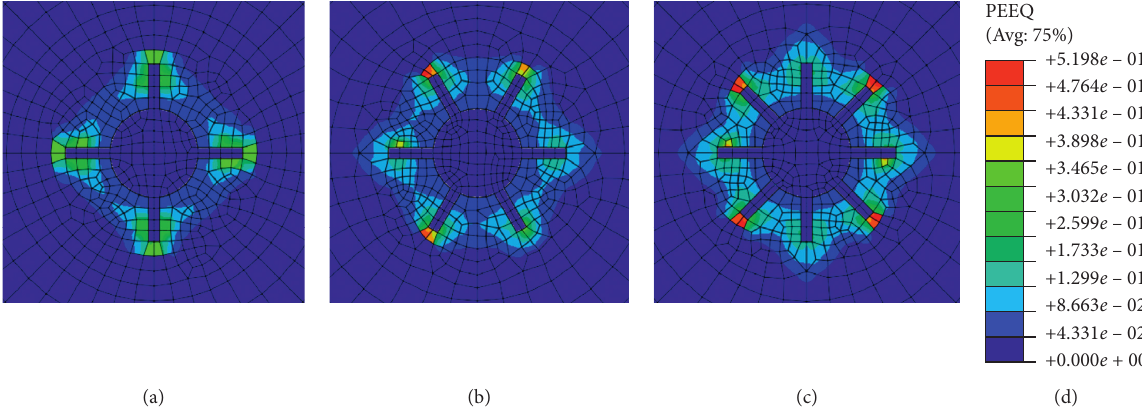
Figure 7: Plastic zone distribution of RP. (a) RP No. 3. (b) RP No. 4. (c) RP No. 5. (d) The legend. In Figure 7(d), PEEQ, which means equivalent plastic strain, is the cumulative result of plastic strain during the entire deformation process. The legend of Figures 10, 11, and 20 is the same as that of Figure 7(d).